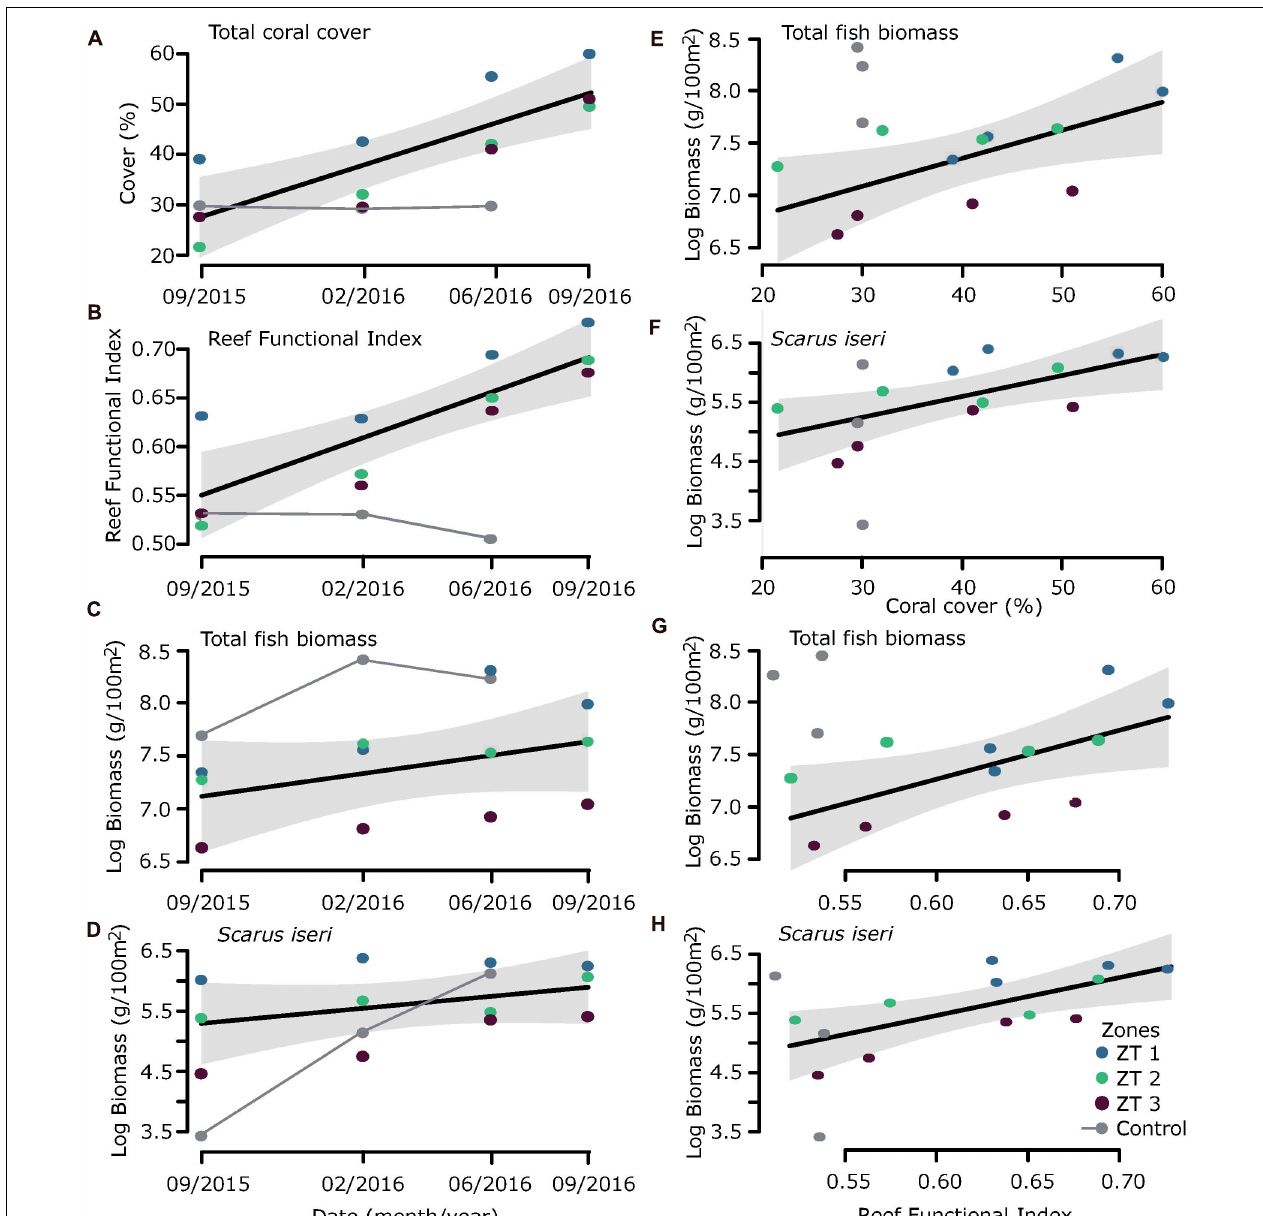
FIGURE 3 | Ecological benefits due to outplanting. Considering date as a descriptive variable (A) coral cover, (B) Reef Functional Index (RFI), (C) total fish biomass, and (D) Scarus iseri biomass. considering Coral cover and RFI as a proxy of habitat complexity, reflected increase in (E,G) total fish biomass and (F,H) Scarus iseri